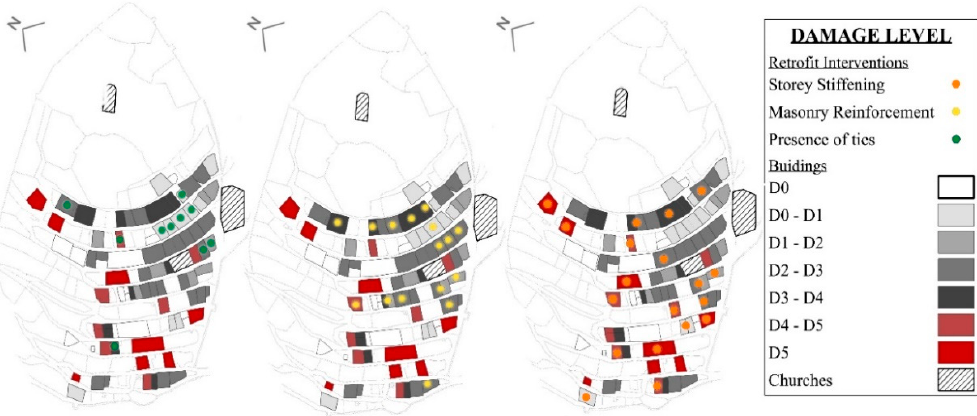
Figure 7. Comparison between the damage level and different retrofit typologies carried out before the seismic.